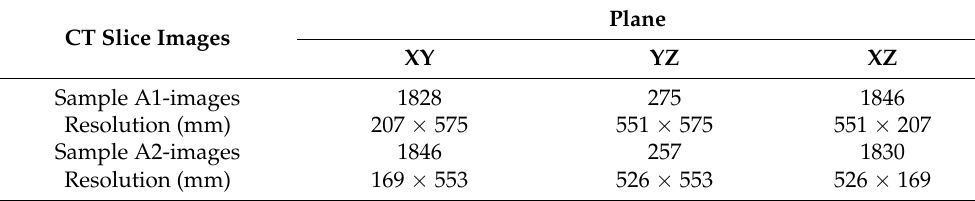
Table 2. The number of CT slice images made along planes and their resolutions (approx).